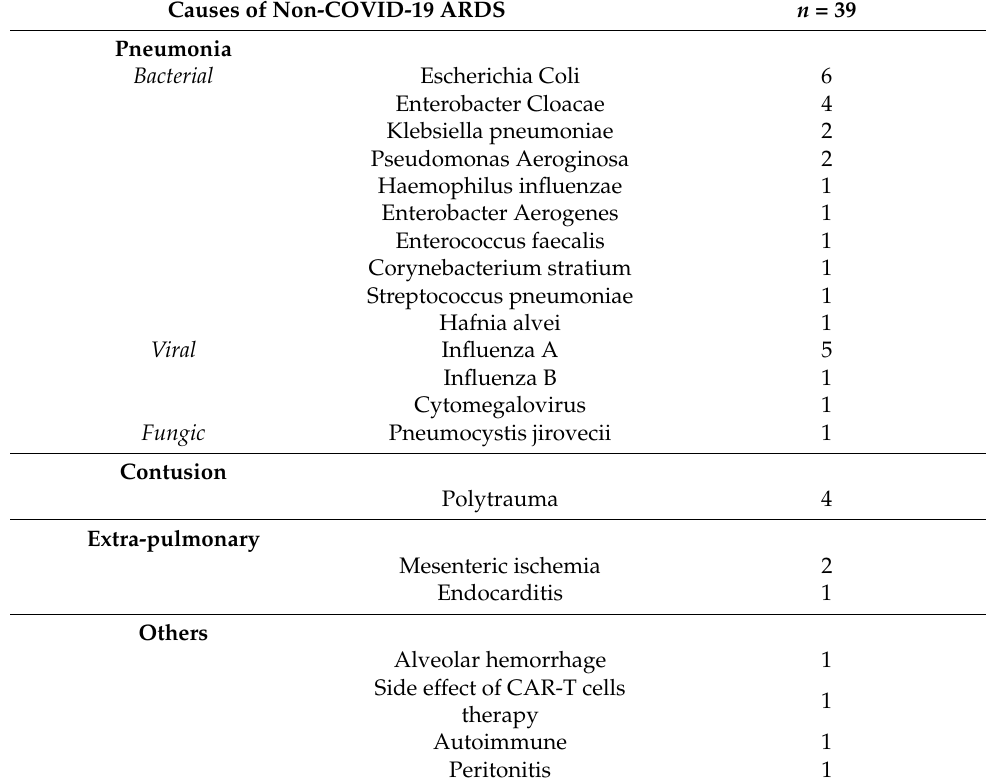
Table 1. Causes of ARDS in non-COVID-19 patients.